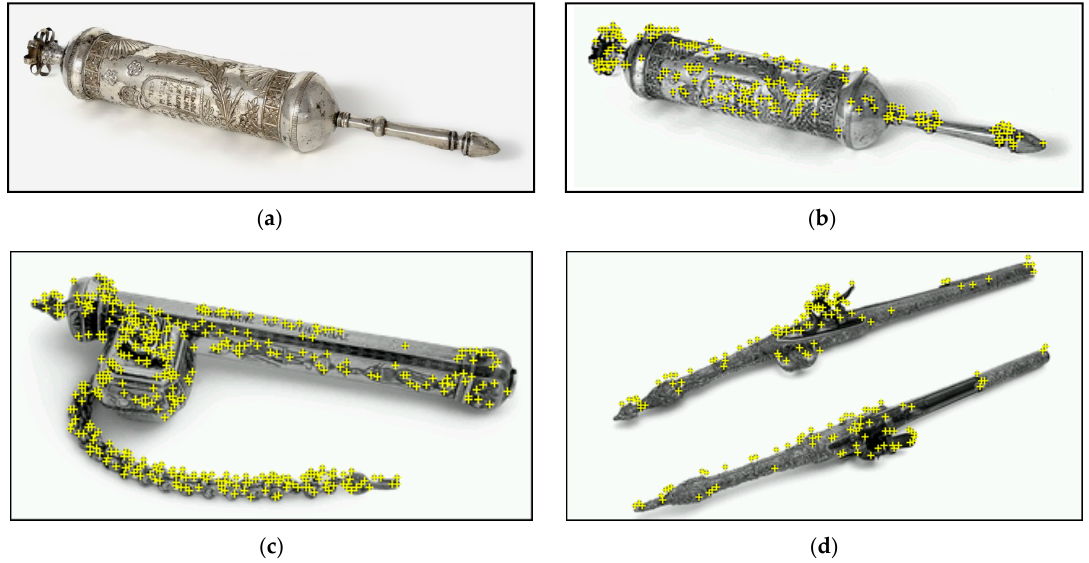
Figure 4. Museum artefacts used as AR markers: ( a ) example of original picture evaluated by the object detection algorithm as a 3-star marker, ( b ) optimized picture evaluated as a 4-star marker for the same object, ( c ) a second example of a 4-star object marker (inkwell), ( d ) another example of an object marker seen from two different angles (pistol).